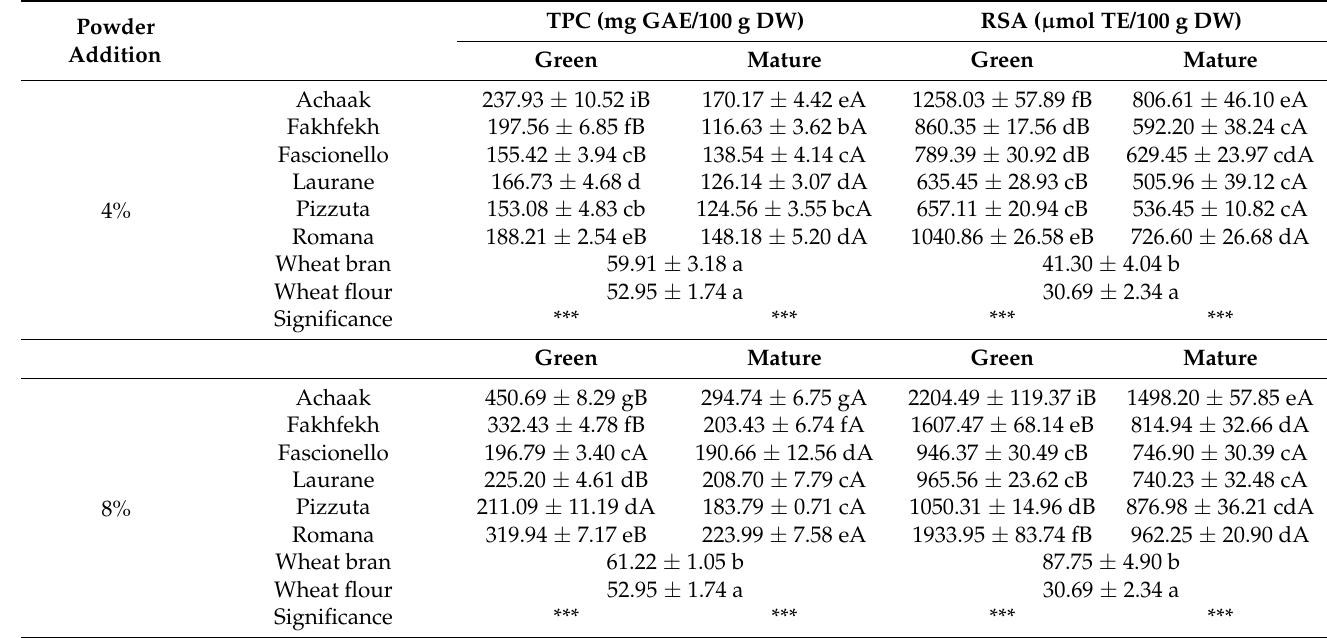
Table 9. Total phenolic content (TPC) and radical-scavenging activity (RSA) of breads fortified with AH powders, and results of variance analysis with Duncan’s test ( p < 0.05) performed between the products and the two harvesting times (green and